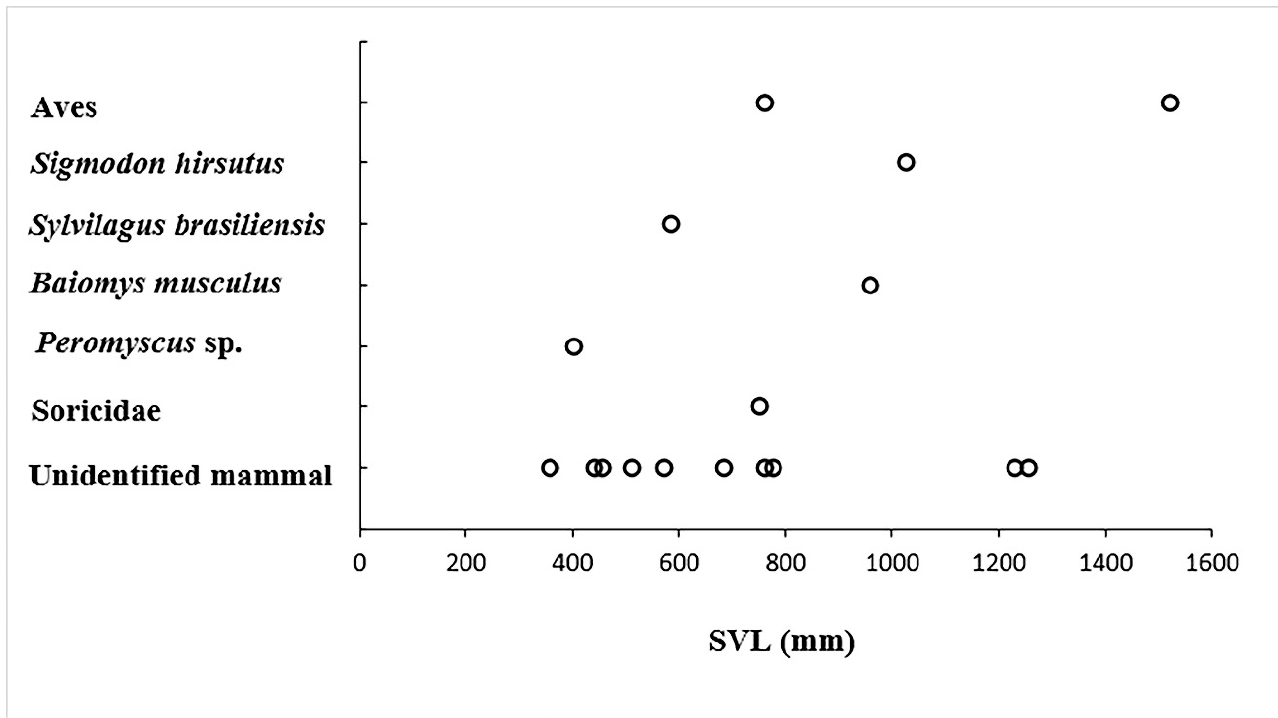
Figure 2. Relationship between prey types (Aves and six different mammal categories) and snake snout–vent length (SVL, in mm) of individuals of Tehuantepec Isthmus rattlesnake ( Crotalus ehecatl ). Snout-vent length ranged between 343 and 1519 mm (776.7 ± 319.2; n = 42) and TTL between 371 and 1656 mm (846.10 ± 348.23 mm; n = 42). The largest male in our sample measured 1532 mm TTL (SVL = 1381 mm, TL = 151 mm), and the largest